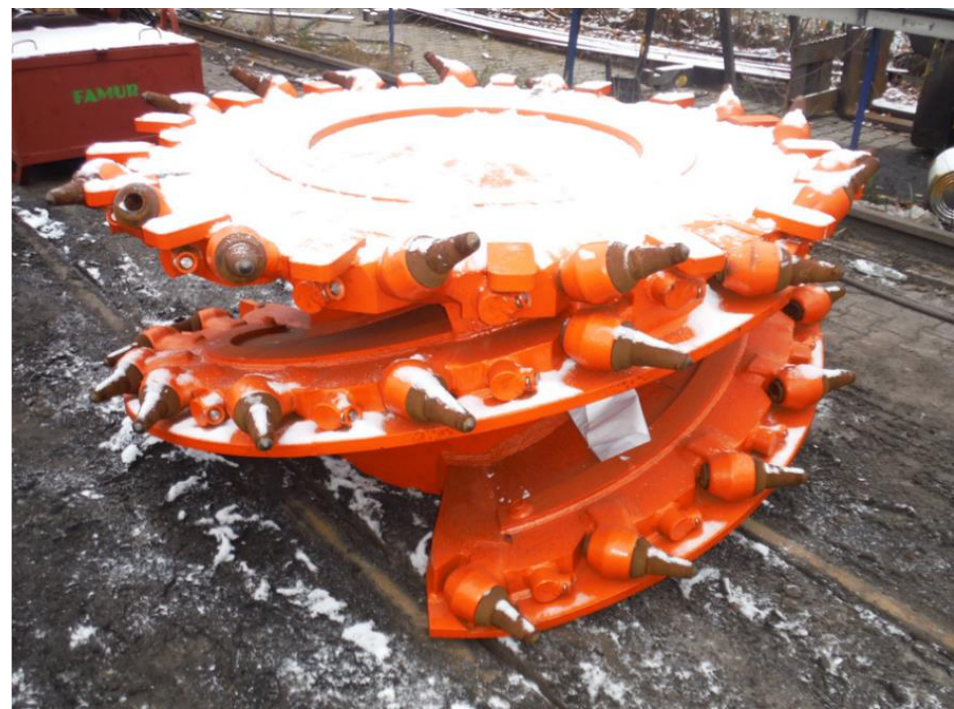
Figure 9. View of the analysed ⌀ 2030 × 800 cutting head.